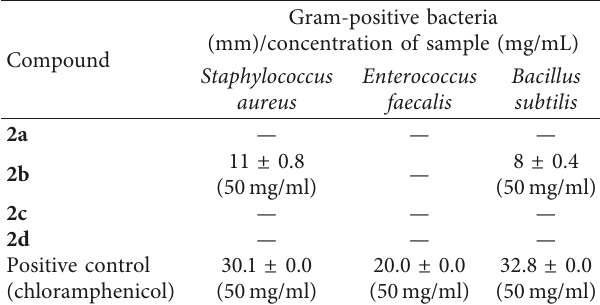
Table 1: Antibacterial screening of compounds 2a , 2b , 2c , and 2d . Gram-positive Compound